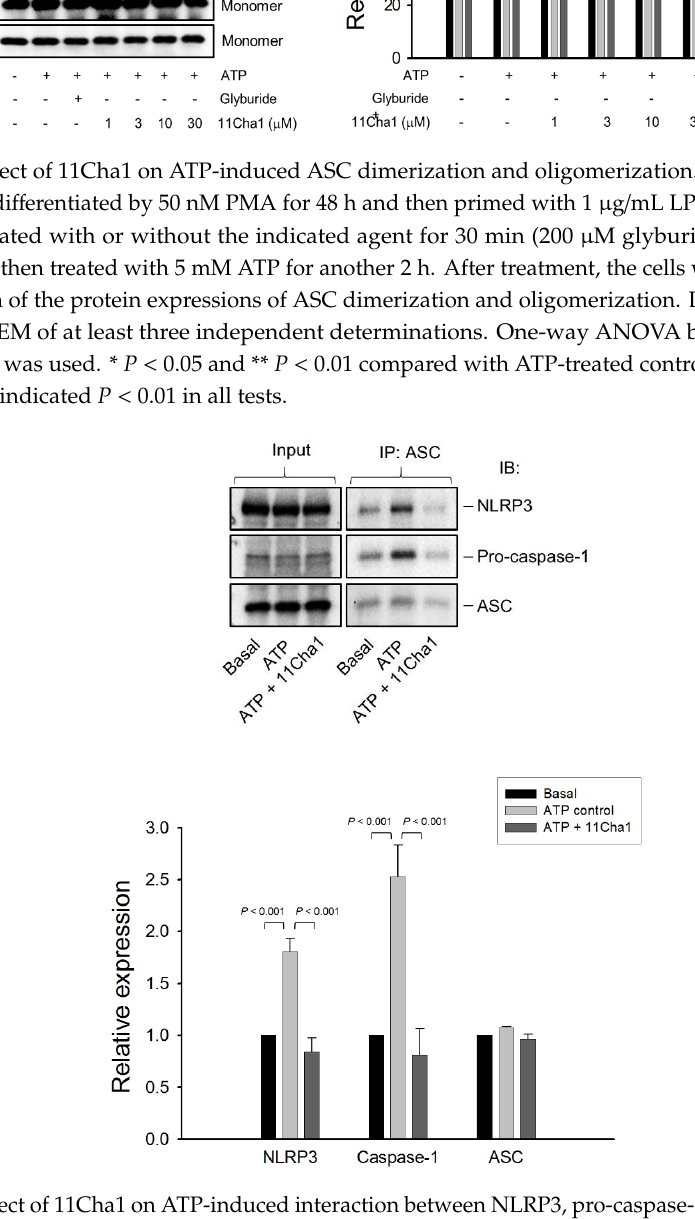
Figure 5. Effect of 11Cha1 on ATP-induced interaction between NLRP3, pro-caspase-1, and ASC. THP-1 cells were seeded and differentiated by 50 nM PMA for 48 h and then primed with 1 μg/mL LPS for 4 h. The cells were pre-treated with or without 11Cha1 (30 µM) for 30 min and then treated with 5 mM ATP for another 2 h. After treatment, immunoprecipitation and immunoblotting experiments were performed. Data are expressed as mean ± SEM of four independent determinations. One-way ANOVA by Newman Keuls post hoc test was used. The analyses of P (ANOVA) indicated P < 0.001 in all tests.